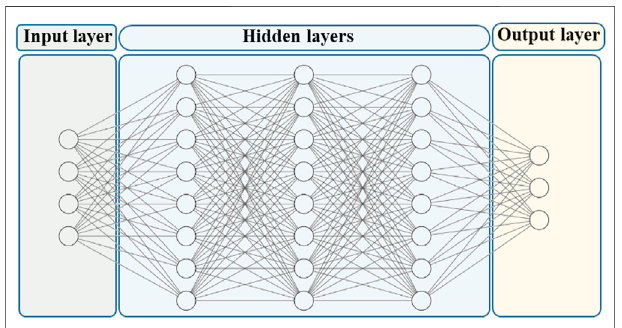
FIGURE 2 | Architecture of a typical FFNN.